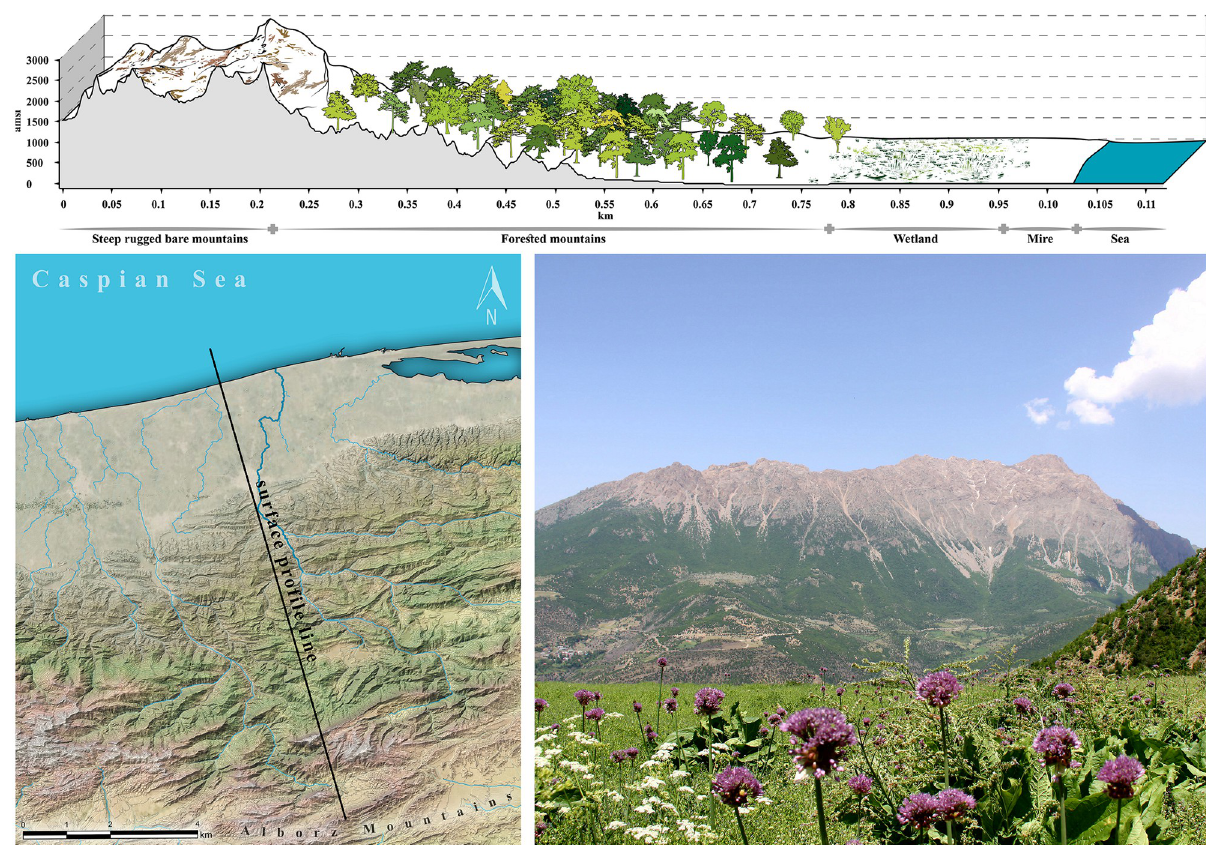
Fig 2. Heterogeneous environment of Southern Caspian Corridor. Figure on top is the reconstruction of the surface profile line depicted in picture low left. Contrast of mountain and plain is depicted on photo low right (photo credit A. Bavand Savadkouhi).